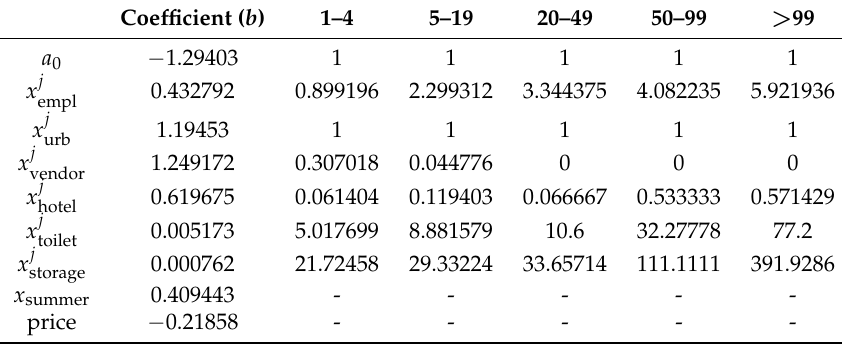
Table 2. Commercial demand function inputs for establishments in different sizes, measured by the number of